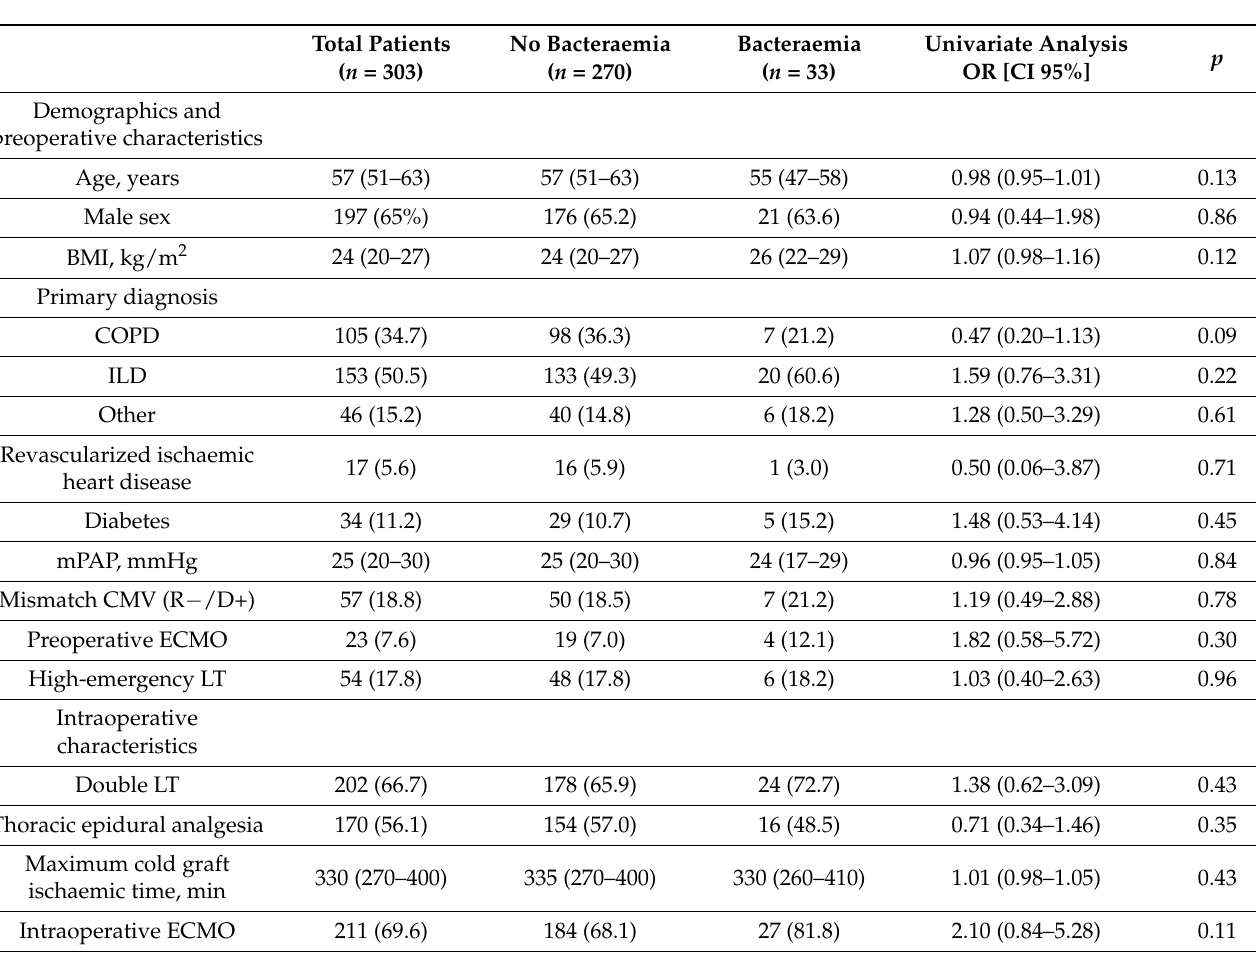
Table 1. Comparison of demographics and preoperative characteristics between lung transplant recipients with and without bacterial bloodstream